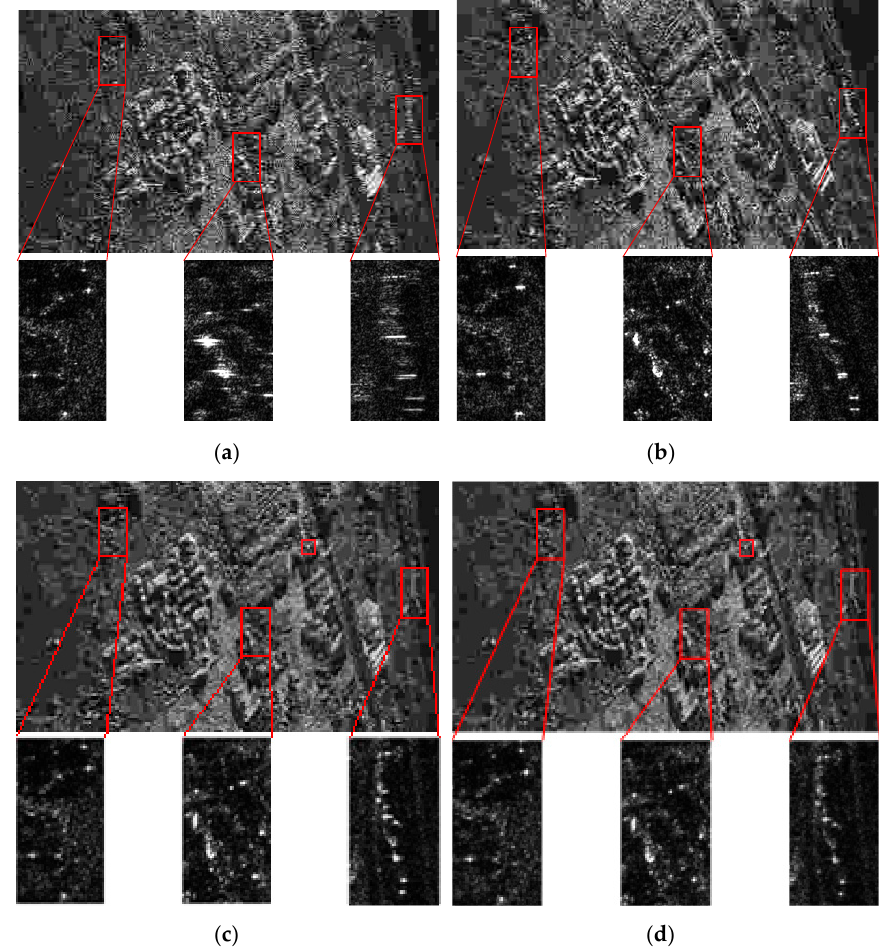
Figure 11. The images of real airborne data based on the different methods. ( a ) The inertial navigation information; ( b ) the basic MAM method; ( c ) the IMAM method; ( d ) the EMAM method.